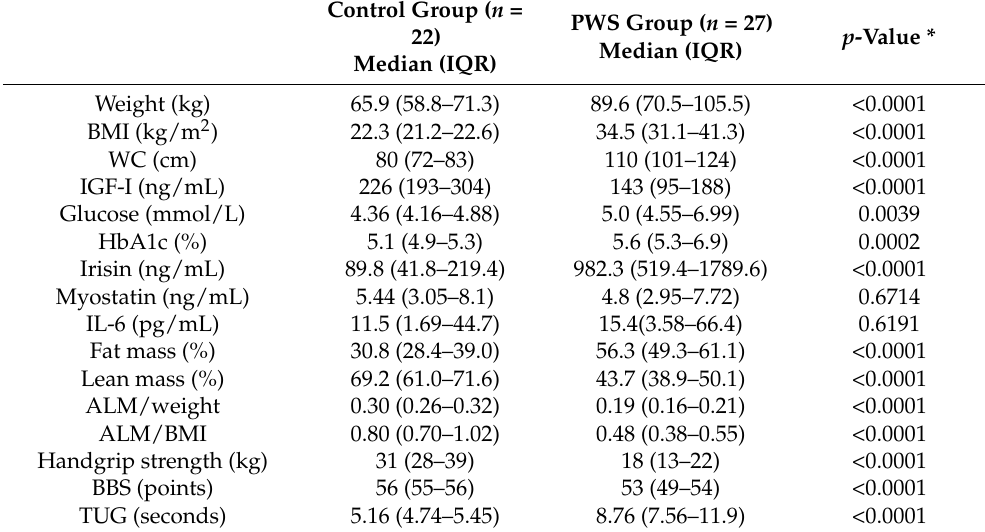
Table 1. Anthropometric, biochemical, and body composition parameters at baseline in the PWS and control